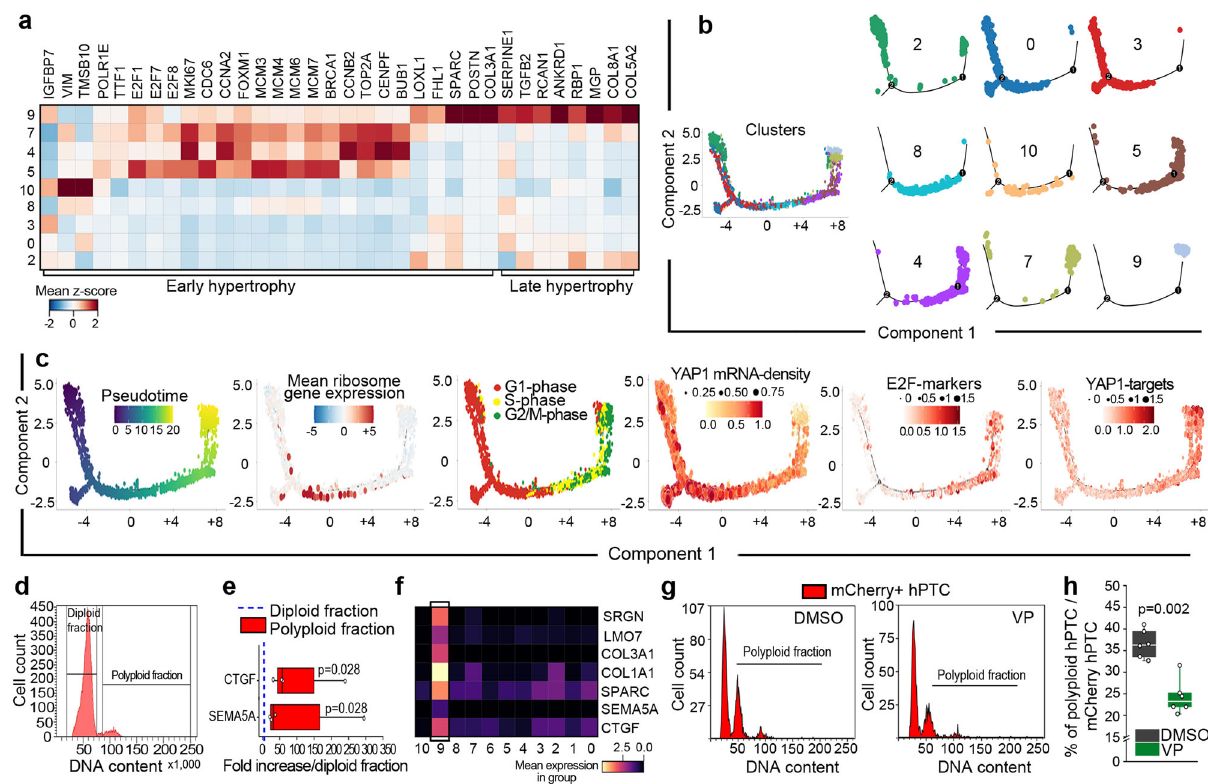
Fig. 2 | Polyploidization of human proximal tubular cells (hPTC) is controlled by YAP1. a Matrix plot of hPTC clusters showing hypertrophy genes. b Monocle2 pseudotime trajectory of hPTC clusters and “ facet ” trajectory (right) showing cluster distribution in order of appearance. c Monocle2 trajectory of hPTC coloured by pseudotime, mean ribosome gene expression difference, cell cycle phases,YAP1mRNAaccumulation,E2F-markers(E2F1,E2F7,E2F8)andYAP1-targets (ANKDR1, BIRC5, CTGF, CDK1, CCNB1, AKT1). d Cell cycle distribution of mCherry-